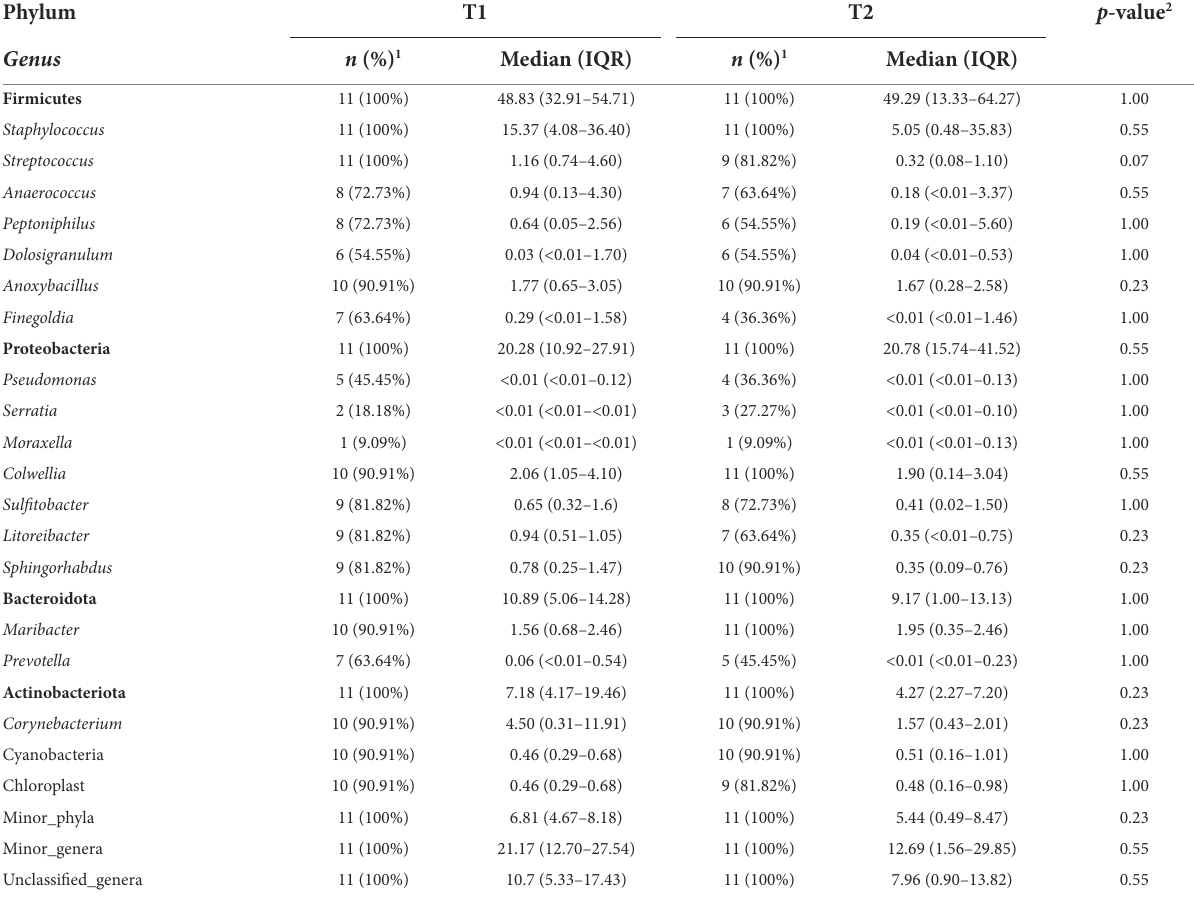
TABLE 4 Relative frequencies, medians and interquartile range (IQR) of the relative abundance (%) of the most abundant bacterial phyla (in bold) and genera (in italics) detected in the fecal samples collected at day 0 (T1) and 120 (T2).